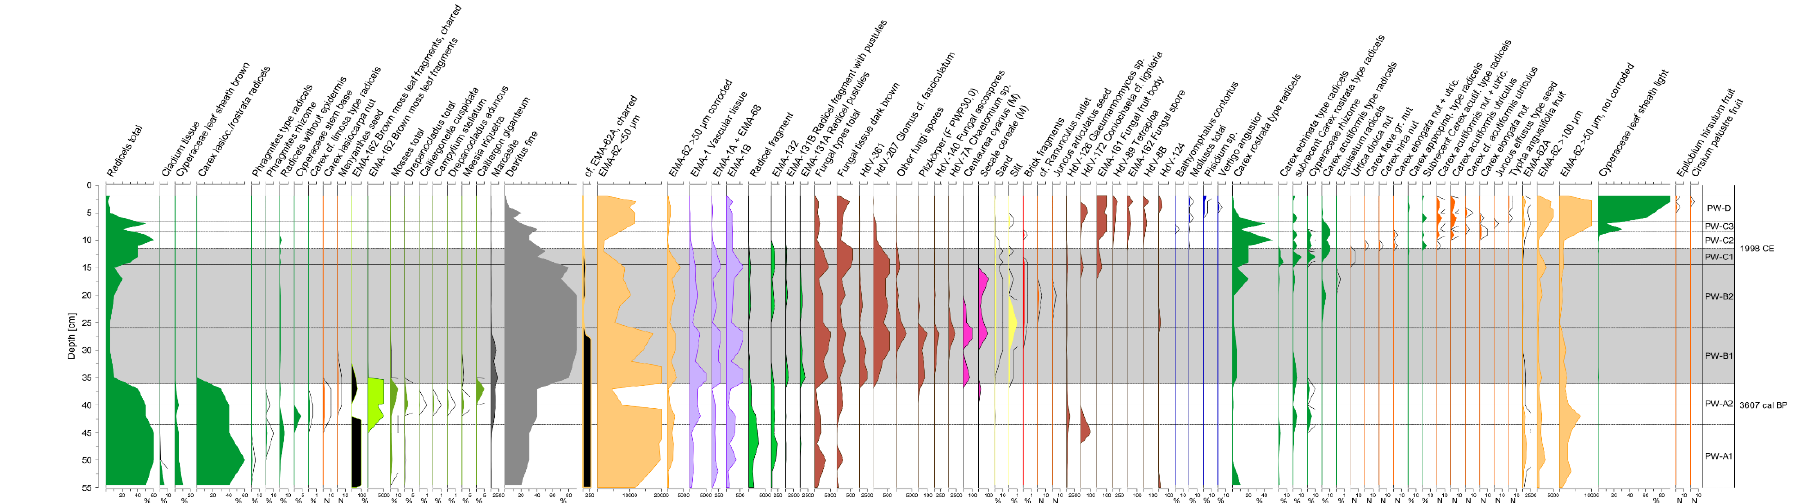
Figure 3. Selected curves of macro- and micro-remain analyses of site Trebel valley (PW). Note the scales and units of the x-axes. Curves show percentages [%] or number [N] of macro-remains as indicated, or otherwise concentrations [10 1 N cm −3 ] of micro-remains.